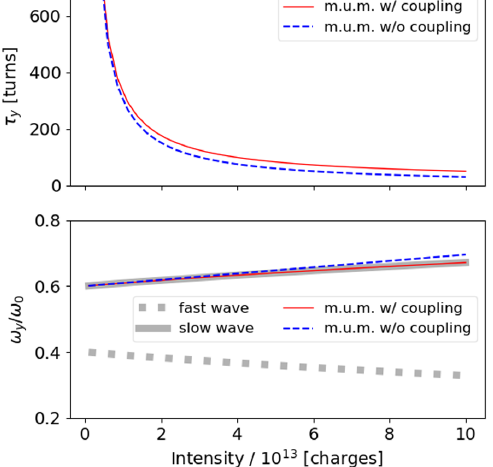
FIG. 4. At the top, the rise time of the most unstable mode (m.u.m.) in the horizontal plane is shown respectively with (red line) and without (dashed blue line) coupling of fast and slow waves. At the bottom, the frequency normalized to the revolution frequency of the m.u.m. with and without coupling is shown together with the normalized frequency shift of the fast (dashed gray line) and slow (full gray line) waves corresponding respectively to n ¼ 6 and n ¼ 7 .